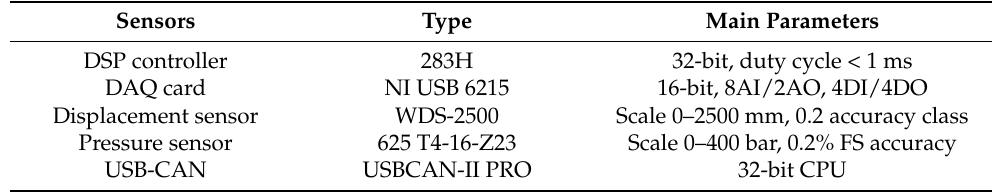
Table 3. Sensors and their parameters used in the experiments.